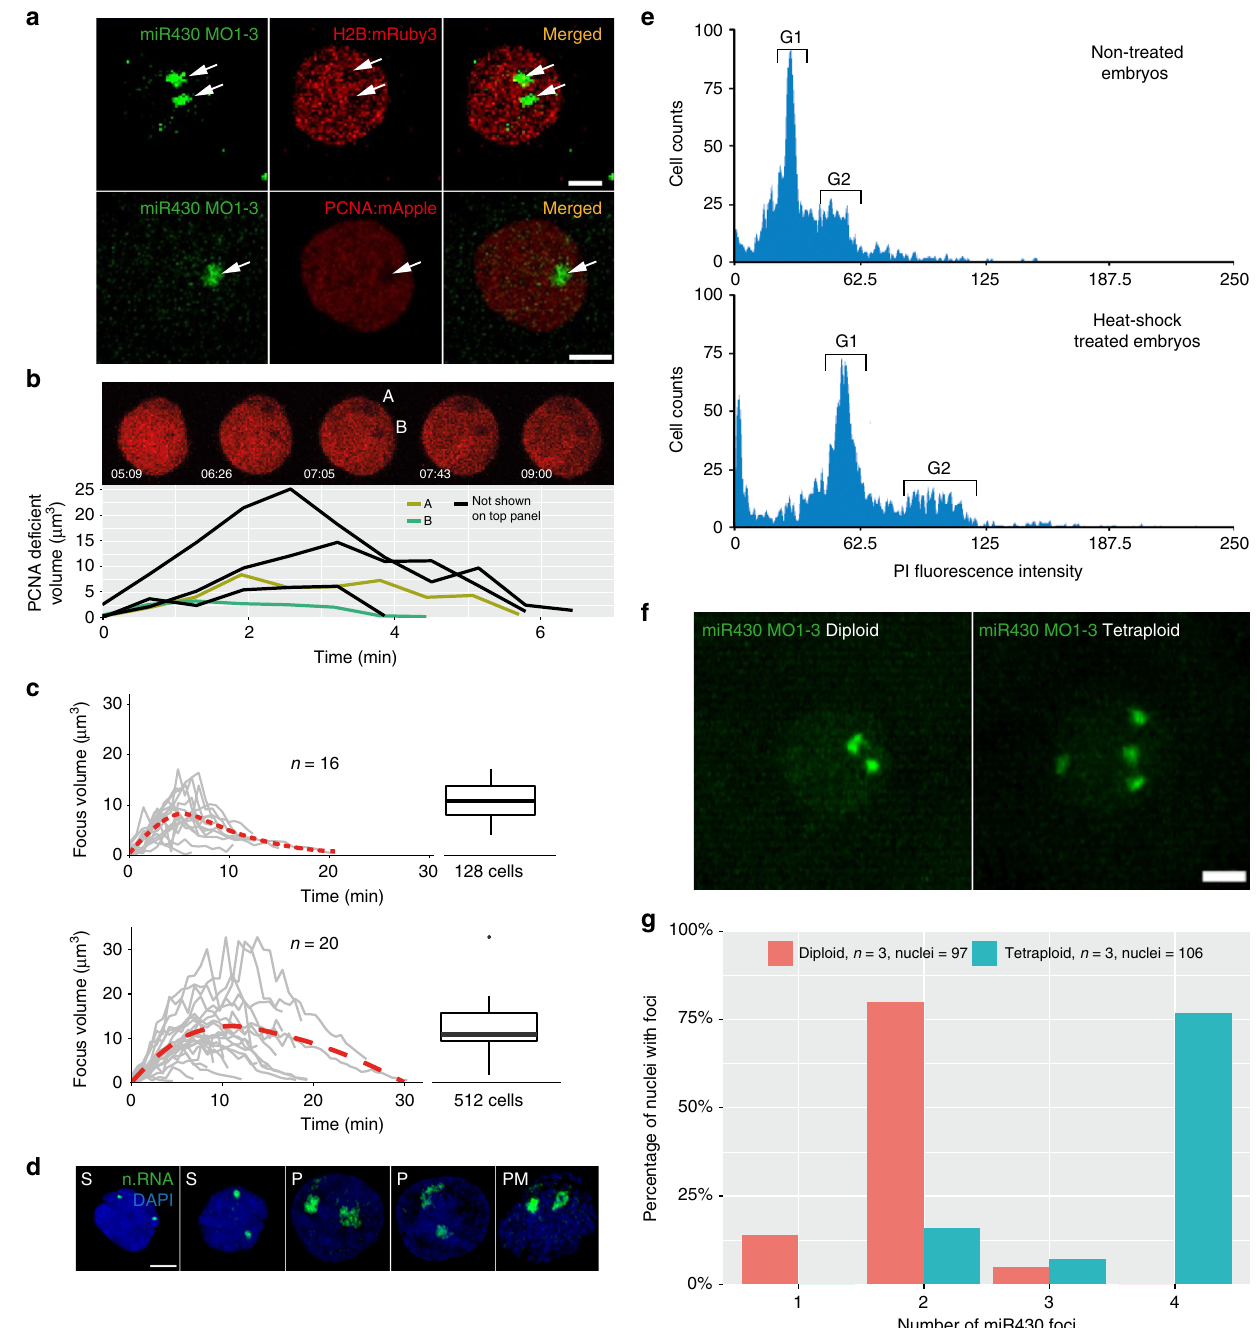
Fig. 6 Relationship of the transcription compartment with the nuclear architecture. a Confocal Airyscan image of 512-cell stage embryos co-injected with miR430 MOs (green) and either mRuby3:H2B (top) or mApple:PCNA (bottom) fusion proteins (red). Arrows indicate low density chromatin at the site of miR430 activity. b Time-lapse of 512-cell stage nucleus, injected with mApple:PCNA fusion proteins (red). Image shows individual z-slices from within the nucleus exhibiting two PCNA de fi cient regions. Graph below shows the evolution of the individual depicted PCNA de fi cient regions over time (A & B), in addition to de fi cient regions from other 512-cell stage nuclei from the same embryo, detected using spot detection plugin in Icy Bioimage. Time indicates duration from fi rst detection of PCNA signal within the cell cycle in seconds and minutes. c Charts representing the transcription focus volume over time based on miR430 MO signal, measured using spot detection plugin Icy Bioimage software, top panel: 128-cell stage, bottom: 512-cell stage. Boxplots on the right show variation in peak volume. Middle line = median. whiskers = nearest hinge±1.5 * interquartile range. d Nascent RNA detection (green) by ethynyl-uridine incorporation and subsequent Alexa fl uor 488 tagging of embryos fi xed in 4min intervals within 512-cells stage, demonstrating different stages of the transcription compartment structure during the cell cycle. e DNA content of 12-somite stage embryos untreated and heat-shocked was determined by propidium iodide DNA staining analysis. FACS traces show a shift in the position of the Gap phase 1 (G1) and Gap phase 2 (G2) peaks (marked), between the heat-shock untreated and treated groups, in accordance with a doubling in DNA content in the heat-shocked group. f Representative images of miR430 MO-injected diploid and induced polypoid 256-cell stage embryos (green). g Bar chart showing comparison of miR430 foci number between diploid and tetraploid embryos. n.RNA nascent RNA, S S-phase, P prophase, PM prometaphase; Scale bar, 5 µ m. Source data for ( b , c , g ) are provided as a Source Data fi le.Source